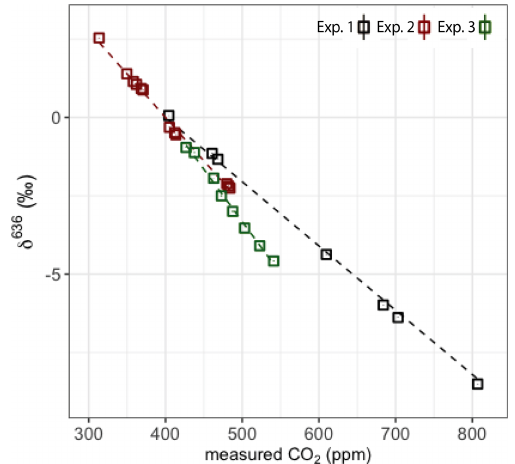
Figure 6. Measured δ 636 of three experiments; black points are ex- periment 1, red points are experiment 2 and green points are exper- iment